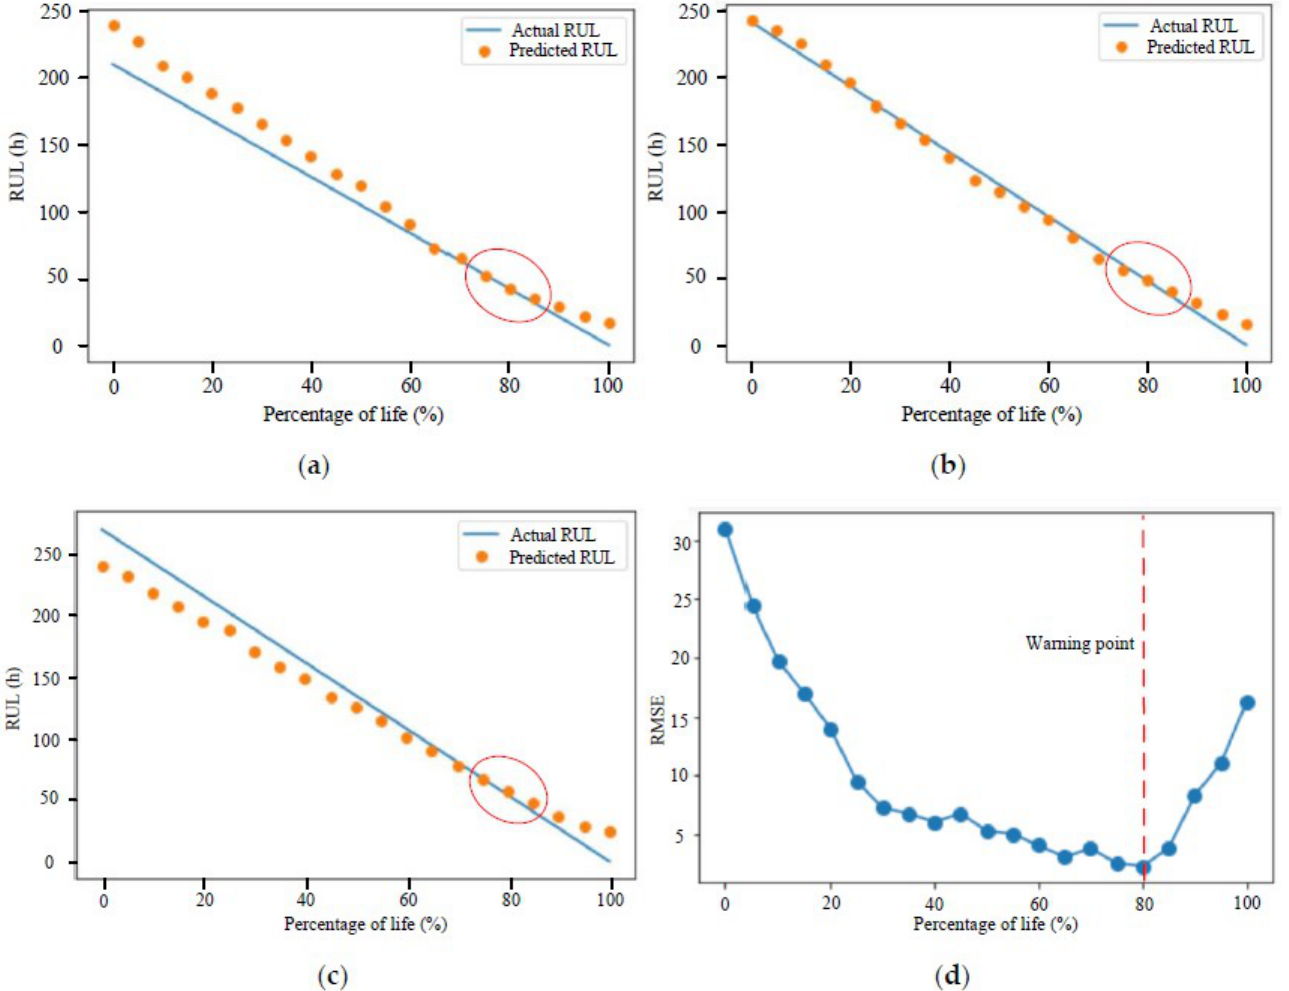
Figure 10. Prediction results. ( a ) Actual working life of 210 h; ( b ) Actual working life of 240 h; ( c ) Actual working life of 270 h; ( d ) RMSE